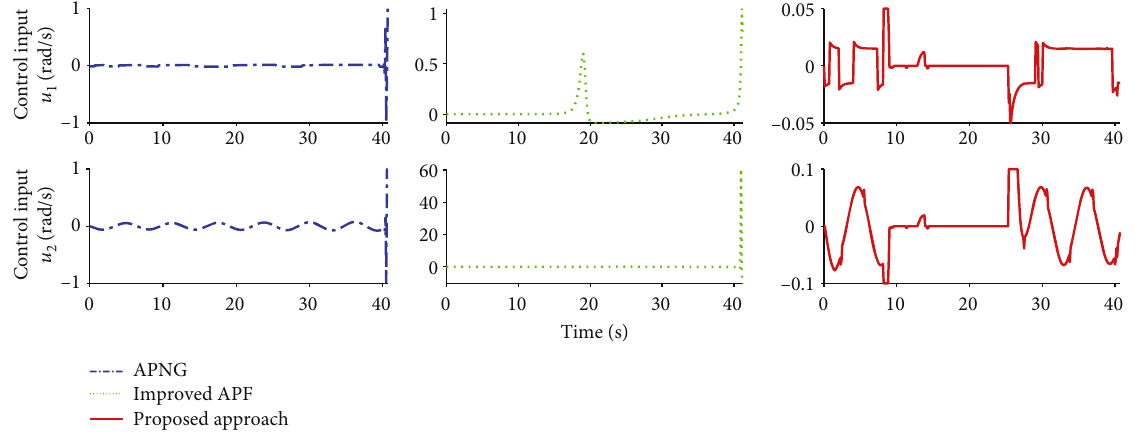
Figure 16: Changes of control inputs in case 3.